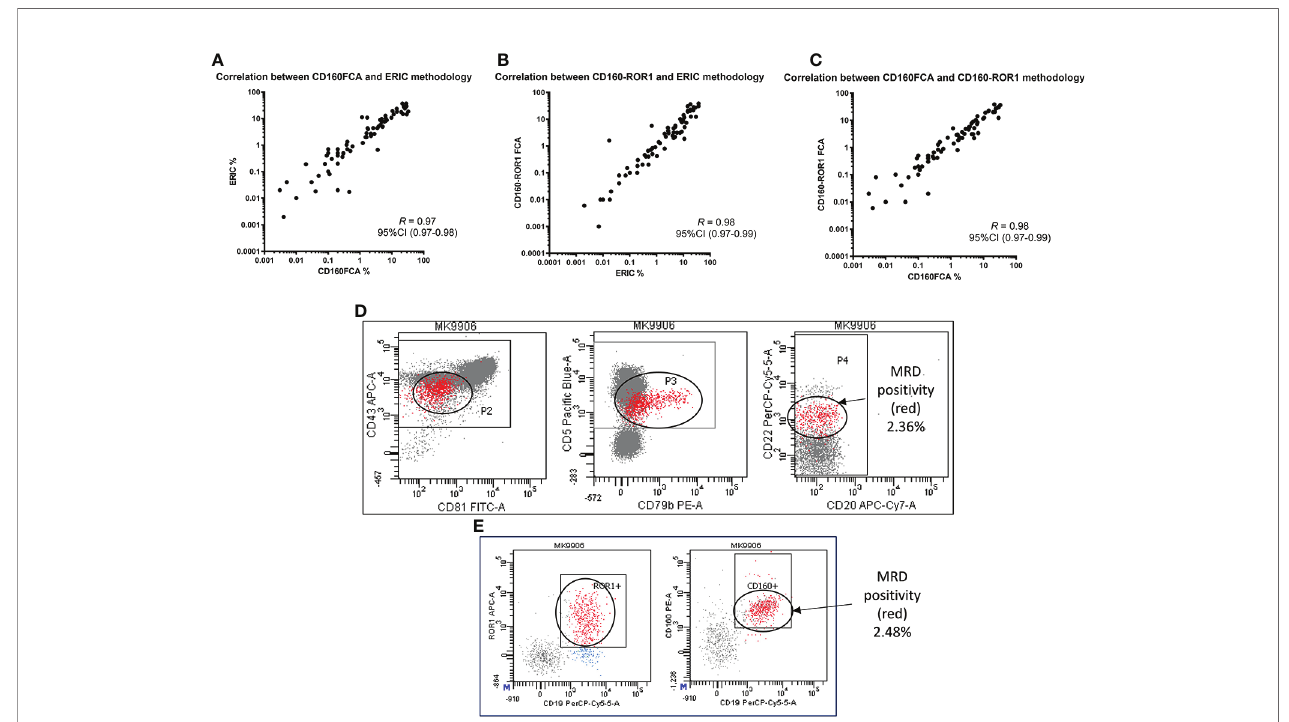
FIGURE 3 | Correlation of MRD detection by CD160FCA, the ERIC protocol and CD160-ROR1FCA. Patient samples (n = 89) were simultaneously assessed for MRD using the three assays. (A) CD160FCA vs ERIC (correlation coef fi cient of R = 0.97, p < 0.01). (B) ERIC and CD160-ROR1FCA ( R = 0.98, p < 0.01). (C) CD160FCA and CD160-ROR1FCA ( R = 0.98, p < 0.01). All MRD results were reported following clear gating on the aberrantly expressed population. (D) Patient MK with identi fi able disease (red population) by ERIC methodology accounting for 2.36% of TNCs. (E) Patient MK with identi fi able disease (red population) by CD160-ROR1FCA methodology, accounting for 2.48% of TNCs.